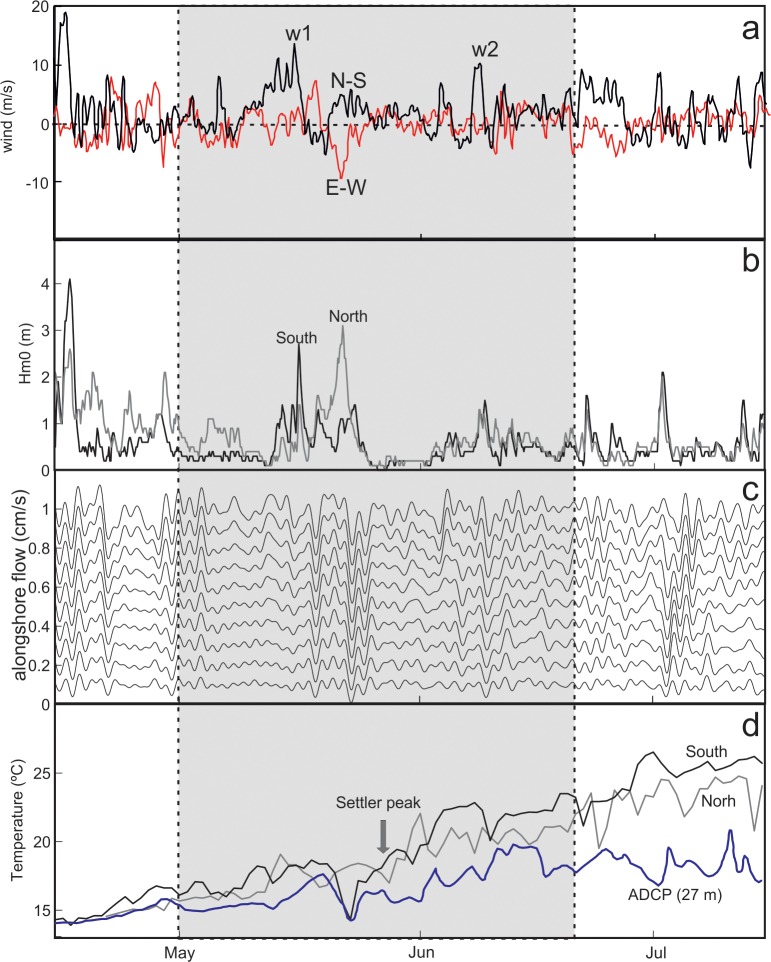
Environmental conditions.The shaded area indicates the sampling period encompassing the settlement and post-settlement period of the white seabream. a) Meridional (N-S back) and zonal (E-W red) components of the wind; b) wave height; c) alongshore oscillatory coastal currents; d) Seawater temperatures. The subsurface temperature (27 m) corresponds to that registered by de ADCP. W1 and W2 indicate two wind events with velocities above 10 ms-1.